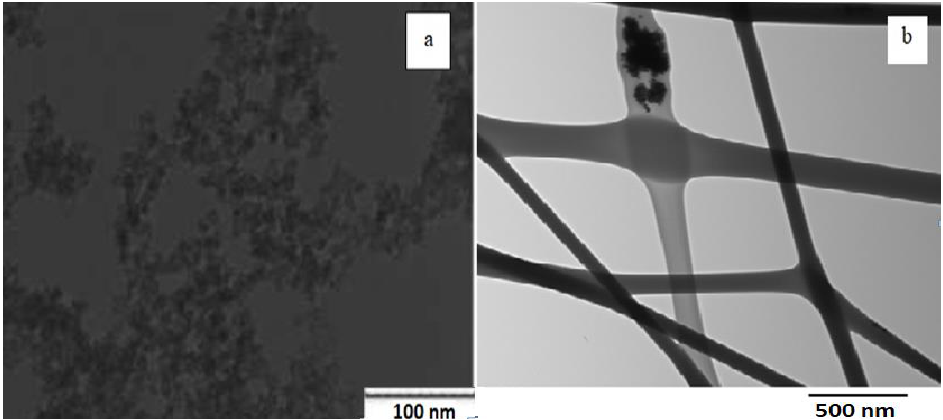
Figure 4. Fluorescence intensity PVA nanofibers(NFs) with in-situ embedded different concentrations ceria NPs.